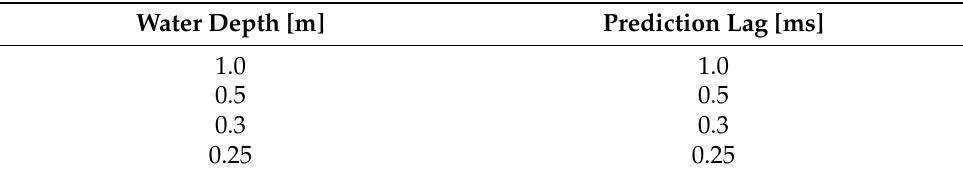
Table 2. Overview of applied parameters for predictive deconvolution in VISTA seismic data processing software.